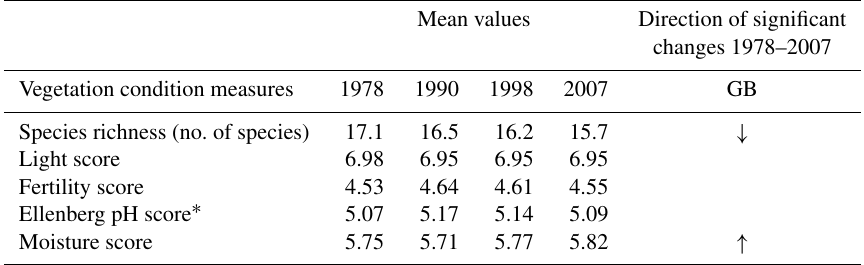
Table 2. Change in the characteristics of all types of vegetation in 200m 2 main plots in Great Britain between 1978 and 2007. Arrows denote significant change ( p < 0 . 05) in the direction